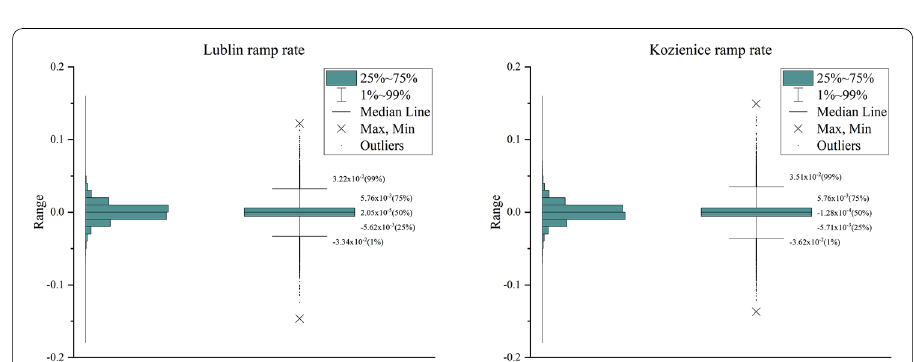
Fig. 3 Probability of observed one-hour ramp rates in the cities of Lublin and